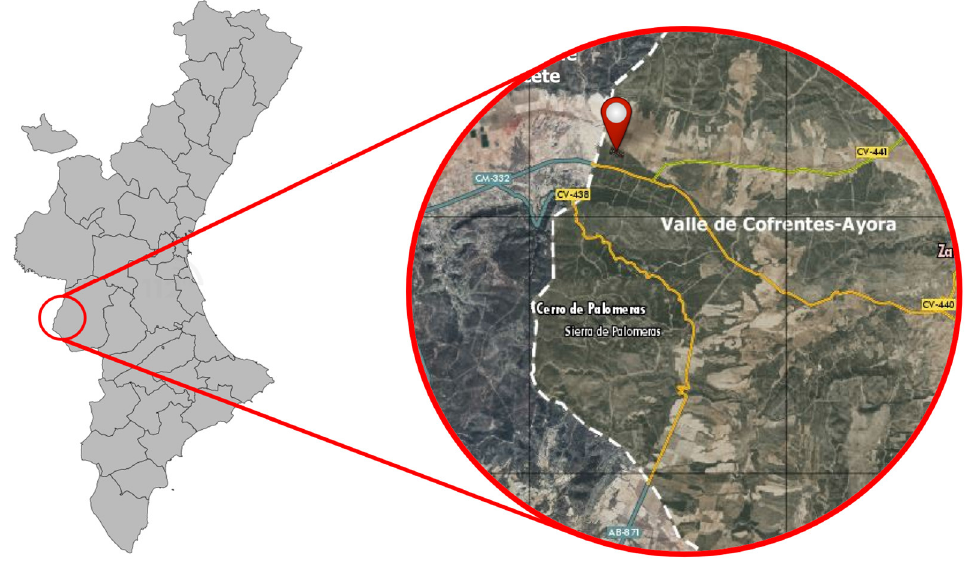
Figure 1. Location map of the study area in Valencia region (Spain).